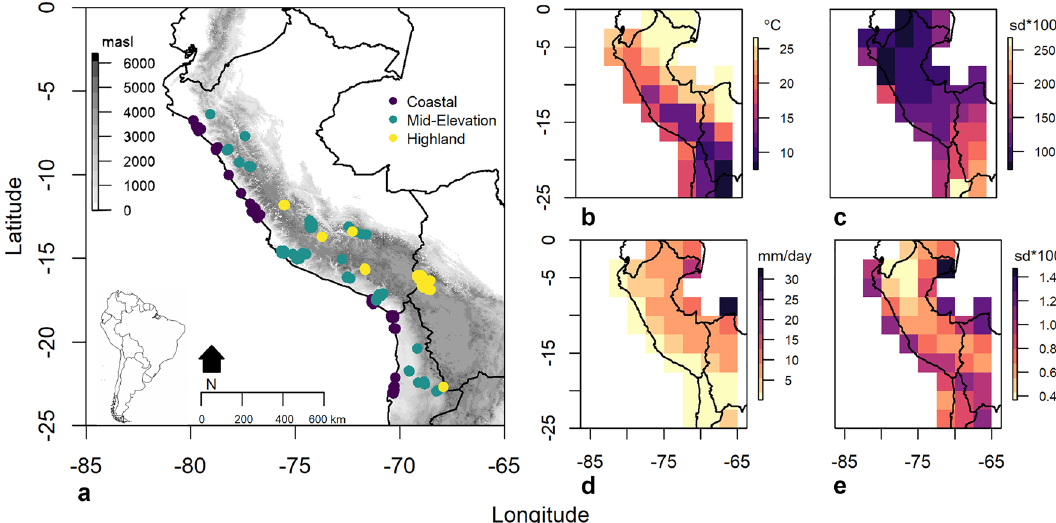
Figure 1. Study area and spatial climate variation. Left: ( a ) Map of locations from which individuals are derived. Colors correspond to the elevation zone. Right: Averaged climate value for each grid cell from the past 7000 years for the study area. Climate variables are ( b ) temperature (°C), ( c ) temperature seasonality (standard deviation in °C * 100), ( d ) precipitation (mm/day), and e) precipitation seasonality (standard deviation in mm/day * 100) generated from TraCE21ka simulations 119,120 through the PaleoView Paleoenvironmental Reconstruction Tool 122 . Maps were produced in the R statistical environment 136 using the mapdata 150 and raster 151 packages with shapefiles obtained from the NOAA Global self-consistent, hierarchical, high-resolution geography database 152